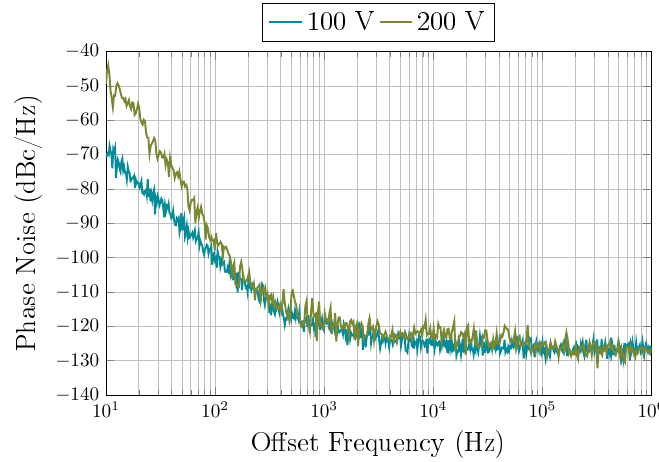
Figure 12. Measured phase noise in vacuum for polarization voltages of 100V and